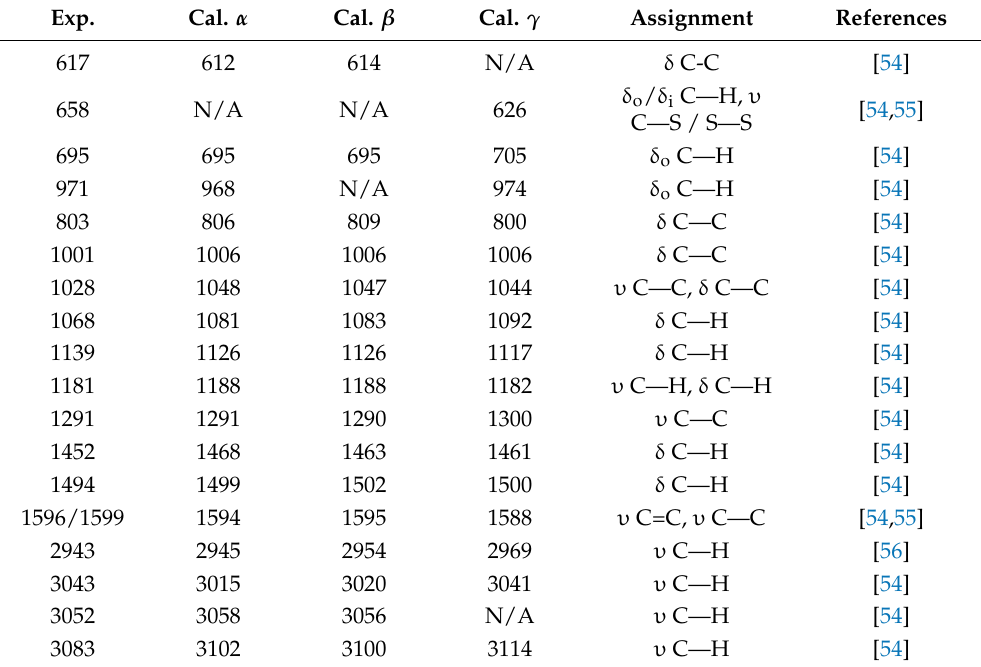
Table 2. Experimental and calculated IR spectra wavenumbers (cm − 1 ) with mode assignments, where, υ : stretching, δ : Bending, δ o : out-of-plane bending, δ i : in-plane bending, N/A: not available. Exp. Cal. α Cal. β Cal.